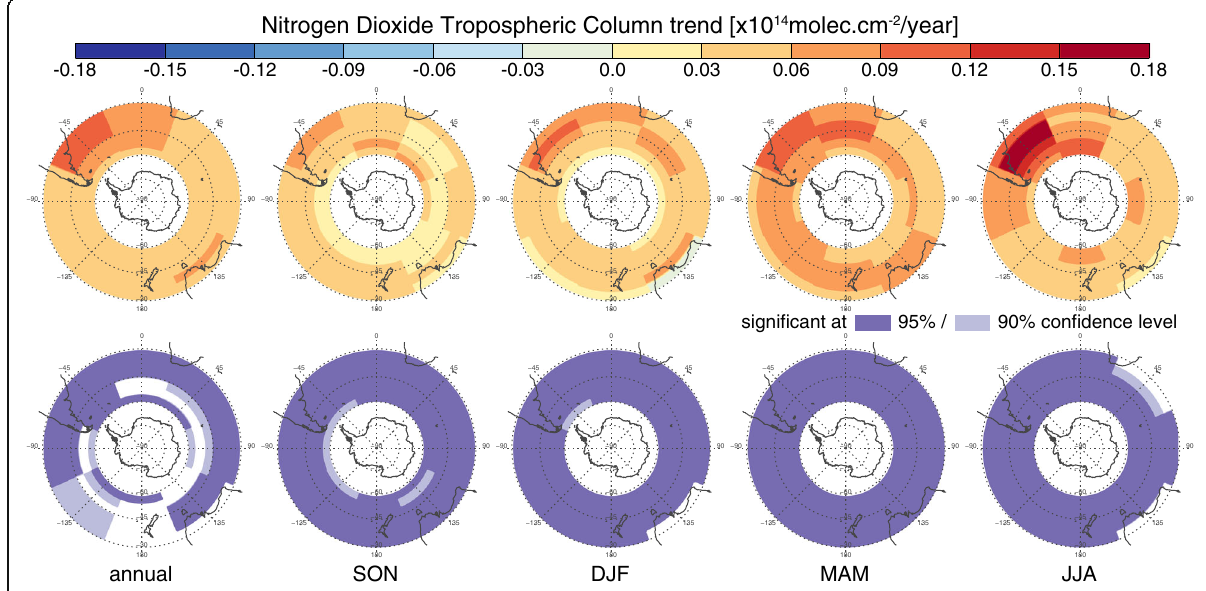
Fig. 9 Spatial distribution of linear trends (top, ×10 14 molecule cm − 2 year − 1 ) and p values (bottom) for deseasonalized tropospheric NO 2 results in the Southern Hemisphere (30 – 60° S) from 2005 to 2016. The first column shows the annual trend; other columns show seasonal trends. The regions showing statistically significant trends are colored deep purple ( p < 0.05) or light purple ( p <